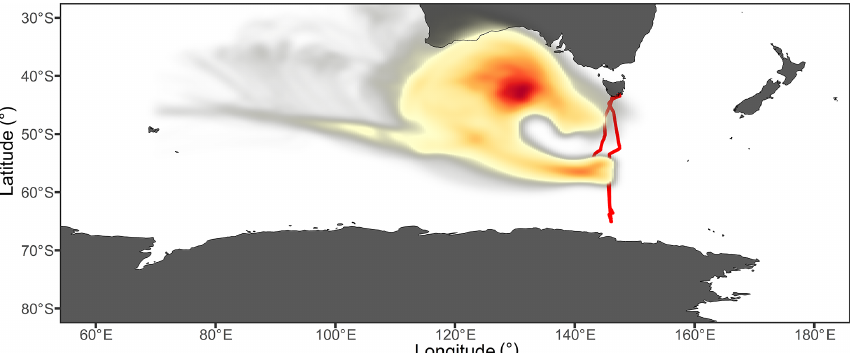
Figure 8. Probability distribution of air mass coordinates throughout all back-trajectory ensembles from the cAU sampling period. The colour scale reflects the proportion of trajectories which passed through each location, with the highest density of trajectories found in the dark red region, which coincided with the approximate centre of a high-pressure system. The ship’s voyage track is represented in red and the ship was located at a mean latitude of 56 ◦ S during this